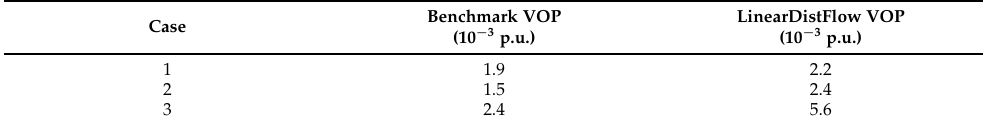
Table 2. Voltage performance index for Benchmark VOP and LinearDistFlow VOP .